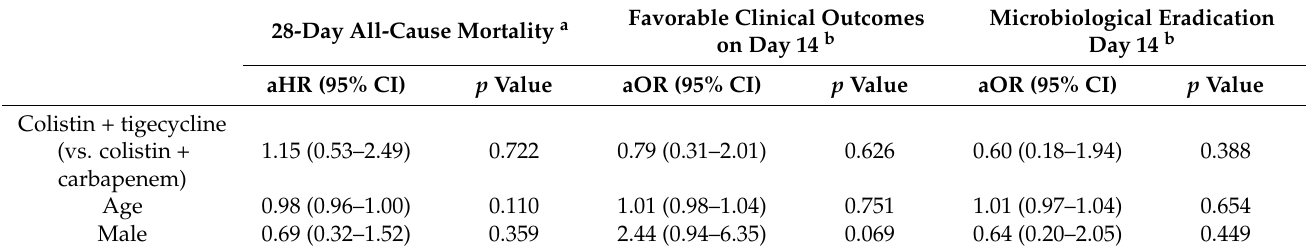
Table 4. Multivariate analysis of clinical factors associated with treatment outcomes after propensity score matching.